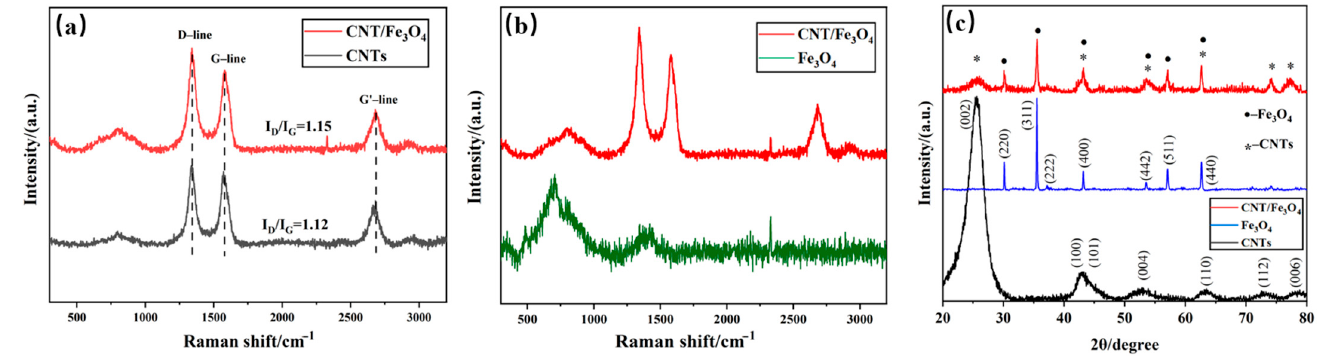
Figure 3. Raman spectral comparison of CNT/Fe 3 O 4 and CNTs ( a ), and CNT/Fe 3 O 4 and Fe 3 O 4 ( b ), XRD of Fe 3 O 4 , CNTs and CNT/Fe 3 O 4 ( c ).